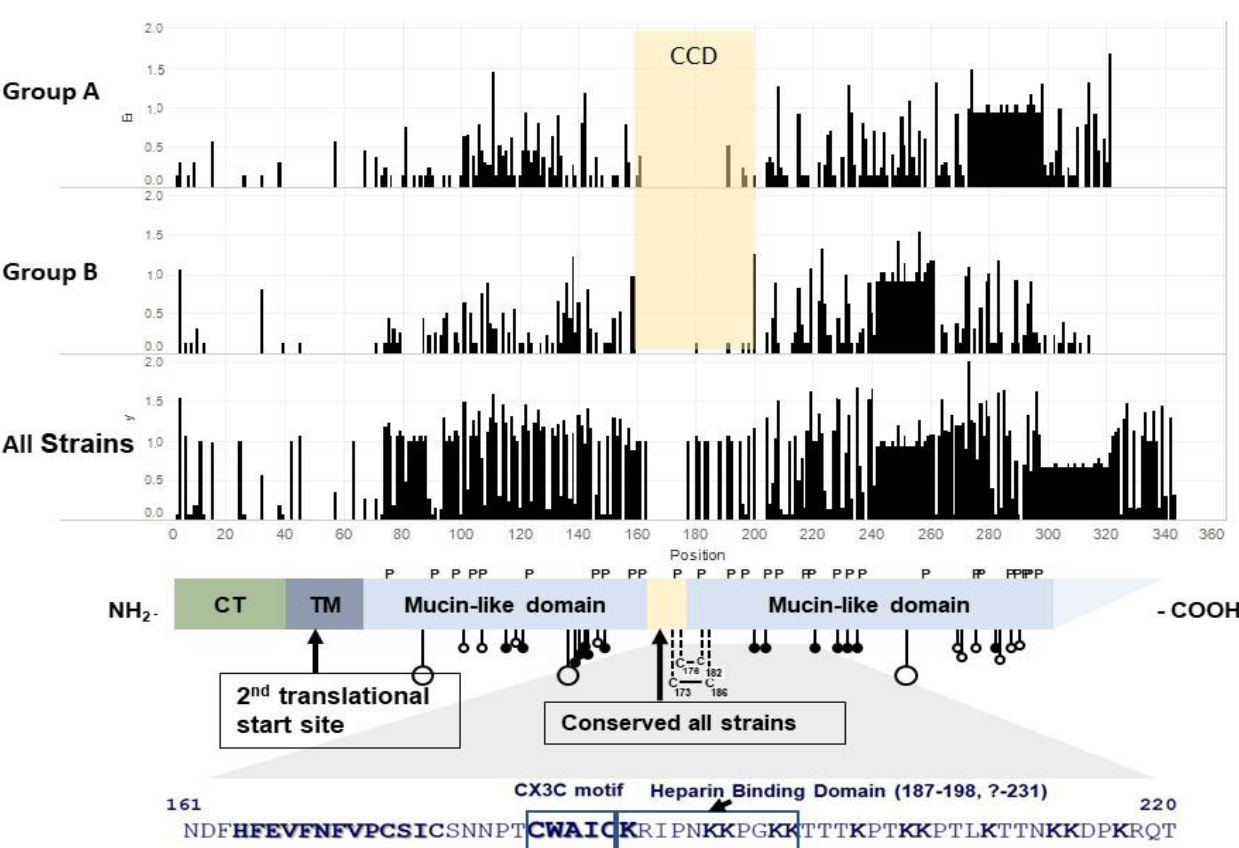
Figure 1. Schematic of the functional domains of the RSV G protein. The first three panels are entropy plots that indicate variability at each amino acid by height of the bar. Sequences were aligned using mafft 7.471, and Shannon entropy M ∑ P i log 2 P i , where P i is the fraction of residues of type I , and M is the total was calculated using the formula H = − i = 1 number of residue type (Wootton, J.C. and Federhen, S., Computers & Chemistry , 1993) [37], using Python code from https://gist.github.com/jrjhealey/130d4efc6260dd76821edc8a41d45b6a (accessed on 6 April 2021). The panels were generated using Tableau 2021.1.0. The 1st panel, Group A, is based on 50 sequences representing the different Group A genotypes. Since some Group A viruses have a 23 aa duplication in G, a gap was included in viruses without the duplication to maintain the alignment. The 2nd panel is based on 53 sequences representing the different Group B genotypes. Since some Group B viruses have a 20 aa duplication in G, a gap was included in viruses without the duplication to maintain the alignment. The 3rd panel is based on the 103 Group A and B sequences used in panels 1 and 2. It includes one gap for the 23 aa duplication in Group A and a second gap for the 20 aa duplication in Group B viruses. The 4th panel is a schematic of the structure of the RSV A2 G gene adapted from Teng et al. (with permission) [38]. P indicates prolines and C cysteine. The stalk with large circles indicates sites for N-linked carbohydrates, and stalks with small circles indicate sites, serine open, and threonine closed, for O-linked carbohydrates. The 13 aa, aa 164–176, conserved among all strains is highlighted in beige. The 5th panel shows aa sequences that include CCD, the CX3C motif (aa 182–186), and the HBD (aa 187–198). CCD is defined in this review as the central relatively conserved domain from ~aa 160 to 200 that is relatively conserved within but not between Group A and B strains. CT = cytoplasmic tail. TM = transmembrane domain. The CX3C motif and K (lysine) are in bold